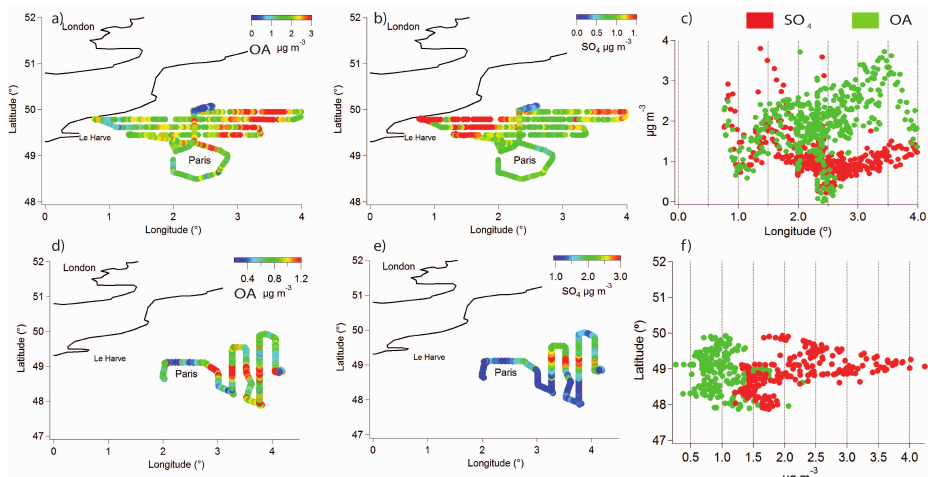
Fig. 4. Flight tracks over the Paris region for N13 (a, b) and E25 (c, d) coloured by SO 4 (b, e) and OA (a, d) . (c) and (f) show OA vs. longitude and latitude vs. SO 4 , respectively.